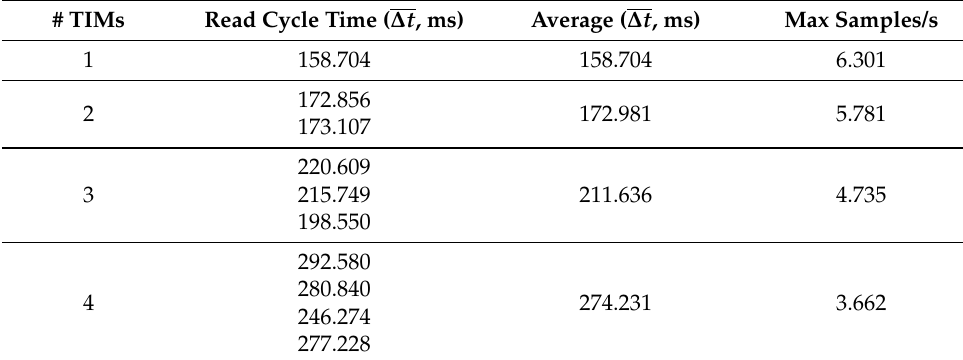
Table 6. Read Sensor Tests—Read Cycle Times, with DINASORE. # TIMs Read Cycle Time ( ∆ t , ms) Average ( ∆ t ,